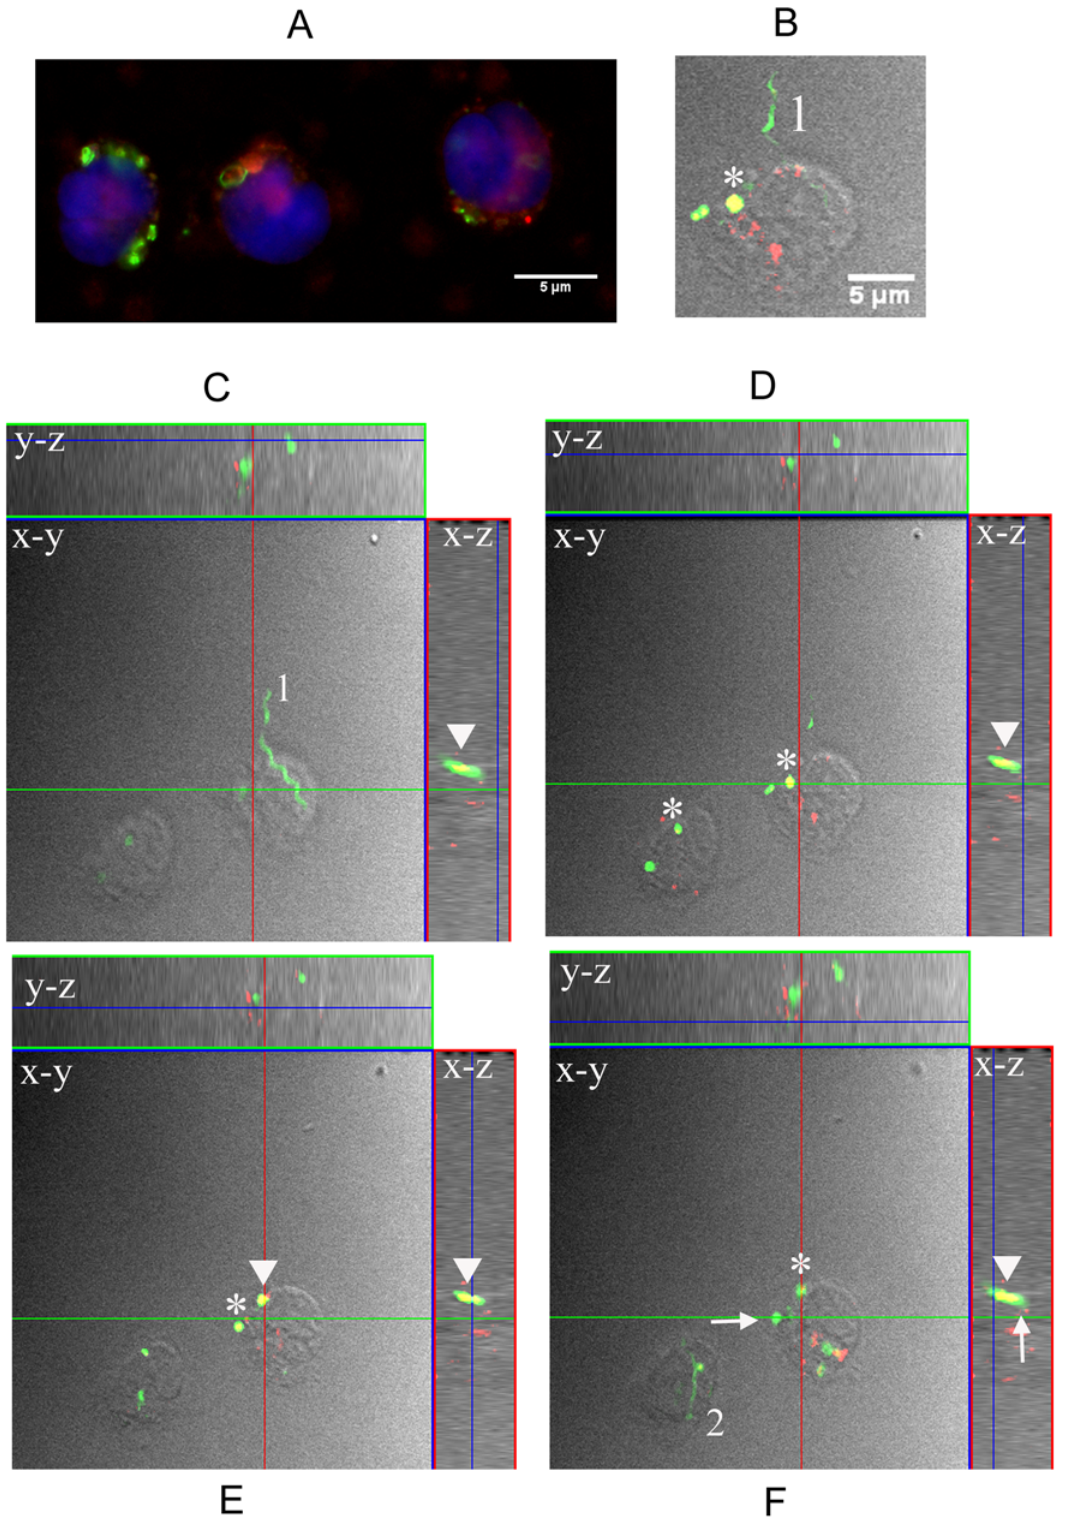
Figure 6. Isolated monocytes contain phagocytosed and degraded B.burgdorferi but not intact spirochetes. (A) Epifluorescence image (100 6 ) acquired from human monocytes incubated for 4-hours with Bb-GFP (MOI 100:1) and labeled with the cell membrane marker FM4-64 (red) and the nuclear dye DAPI (blue). Phagocytosed (both coiled and degraded) Bb-GFP and fragmented nuclei were observed. (B–F) Orthogonal view (y,z and x,z axes) of optical sections (x,y axes) through a confocal stack of isolated monocytes incubated with Bb-GFP (MOI 100:1) and labeled with lysotracker (red). (B) Digital enlargement of an extracellular spirochete (labeled # 1) in close proximity to a monocyte. Panels C–F are presented in 2 m m increments [(C) 6 m m, (D) 8 m m (E) 10 m m and (F) 12 m m] through the depth of the monocytes (total depth=14 m m). Arrows and asterisks point